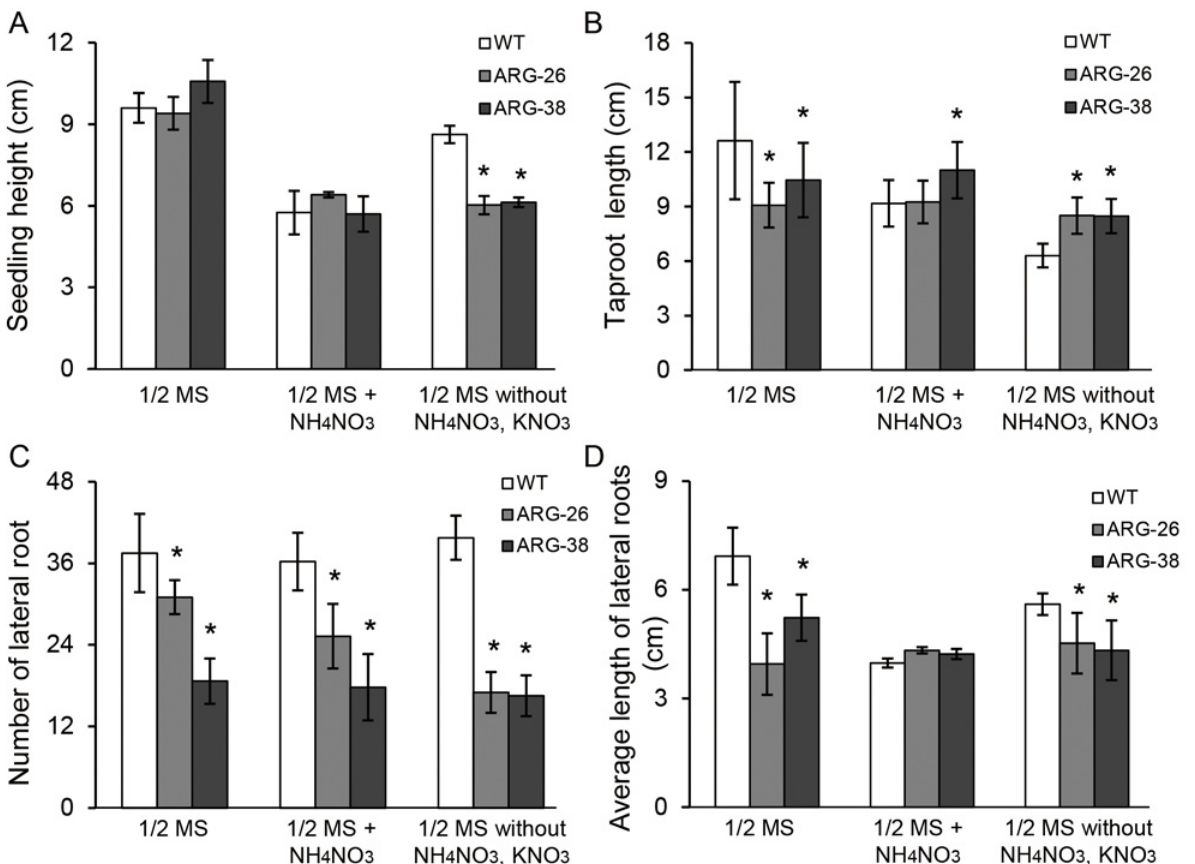
Fig 6. Morphology analyses of transgenic cotton seedlings grown on 1/2 MS medium with varying nitrogen content. T4-generation ARG-26 and ARG-38 cotton seedling were cultured on three kinds of growth media:1/2 MS medium, 1/2 MS medium with 4×NH 4 NO 3 , and 1/2 MS medium lacking nitrogen. Due to the expression of the OsARG gene in cotton, the seedling height, taproot length, lateral root number, and lateral root length of ARG-26 and ARG-38 plants were changed compared with those of non-transgenic control cotton plants. Both of the transgenic seedling heights were same or increased on 1/2 MS medium and 1/2 MS medium with 4×NH 4 NO 3 , but decreased on 1/2 MS medium lacking nitrogen. Both of the transgenic seedling taproot lengths were same or increased on 1/2 MS medium with 4×NH 4 NO 3 and 1/2 MS medium lacking nitrogen, but decreased on 1/2 MS medium. Both of the transgenic seedling lateral root numbers were decreased on 1/2 MS medium,1/2 MS medium with 4×NH 4 NO 3 and 1/2 MS medium lacking nitrogen. Both of the transgenic seedling lateral root lengths were little increased on 1/2 MS medium with 4×NH 4 NO 3 , but decreased on 1/2 MS medium and 1/2 MS medium lacking nitrogen. (A) the seedling height of transgenic cotton was analyzed for plants grown on three kinds of growth media. (B) taproot length was analyzed of transgenic cotton was analyzed for plants grown on three kinds of growth media. (C) and (D) the average number and the average length of lateral roots were analyzed for plants grown on three kinds of growth media for plants grown on three kind growth media. ‘ WT ’ refers to non-transgenic control plants of wild type cotton. * : P < 0.05.